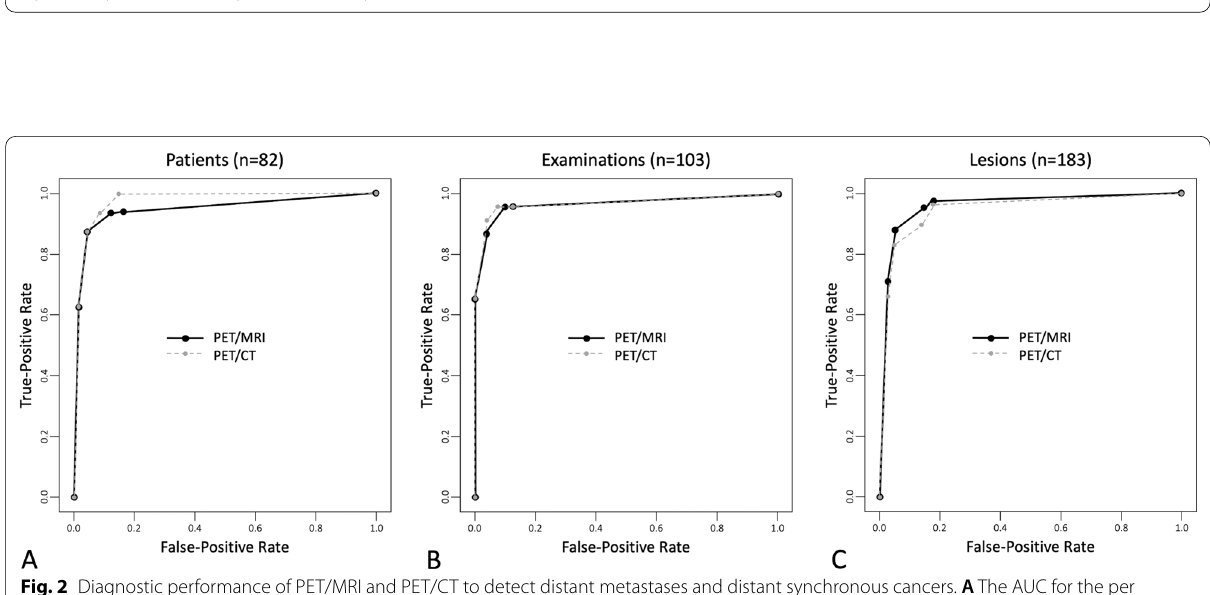
103) was 0.965 [0.917–1] for PET/MRI and 0.968 [0.920–1] = 0.488). C The AUC for the per lesion analysis =